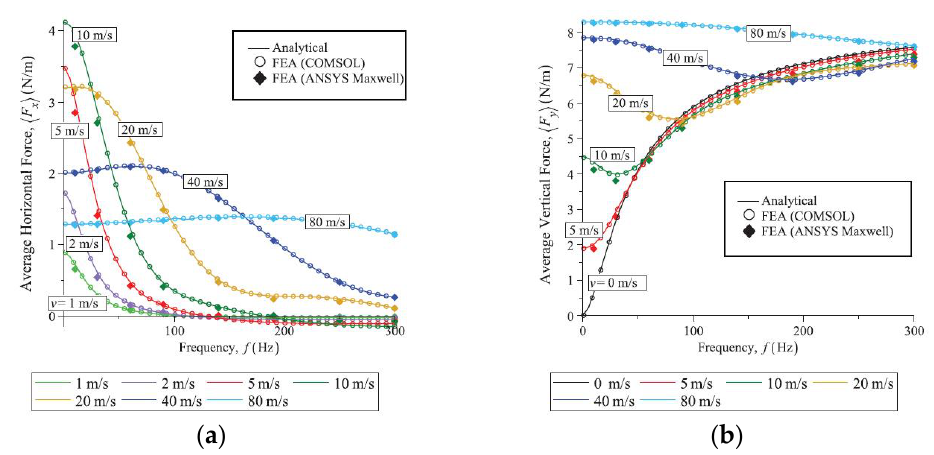
Figure 6. Average horizontal force density ( a ) and average vertical force density ( b ) acting on the coil as a function of frequency for different LIM velocities [61].